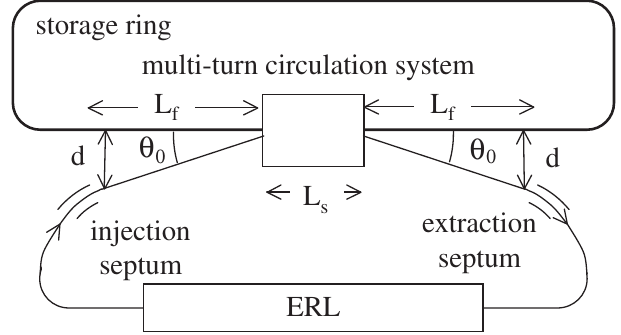
FIG. 9. Configuration of multiturn circulation system in 25 m- long straight section of SPring-8 storage ring. The dimensional parameters in the figure are listed in Table I.